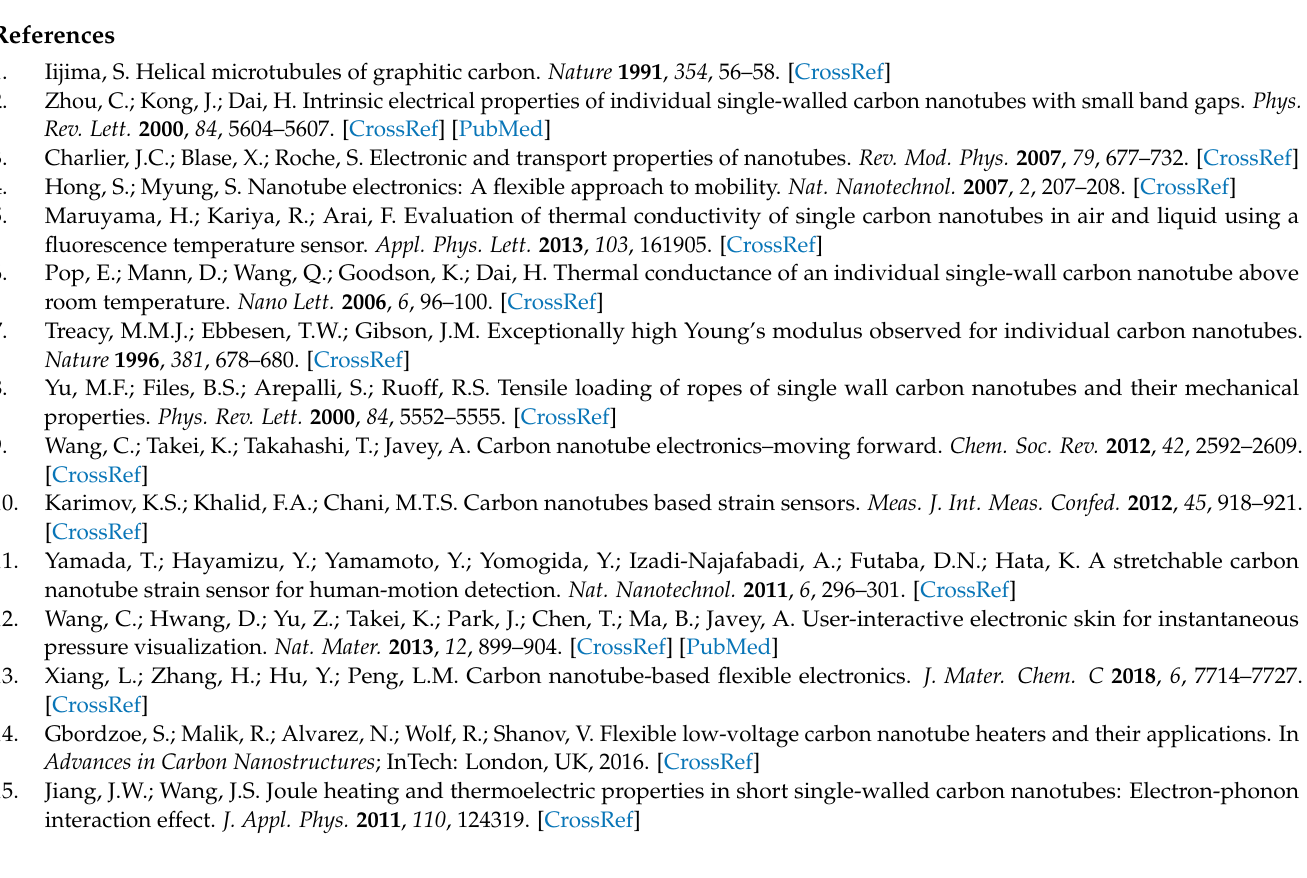
Figure S3: Sheet conductance of as-synthesized CNT sheet in parallel and perpendicular direction, Figure S4: Heating performance under different voltages from samples, Table S1: Heating information of various stretched CNT sheets, Video S1: CNT sock collection process, Video S2: CNT CSA-assisted stretching